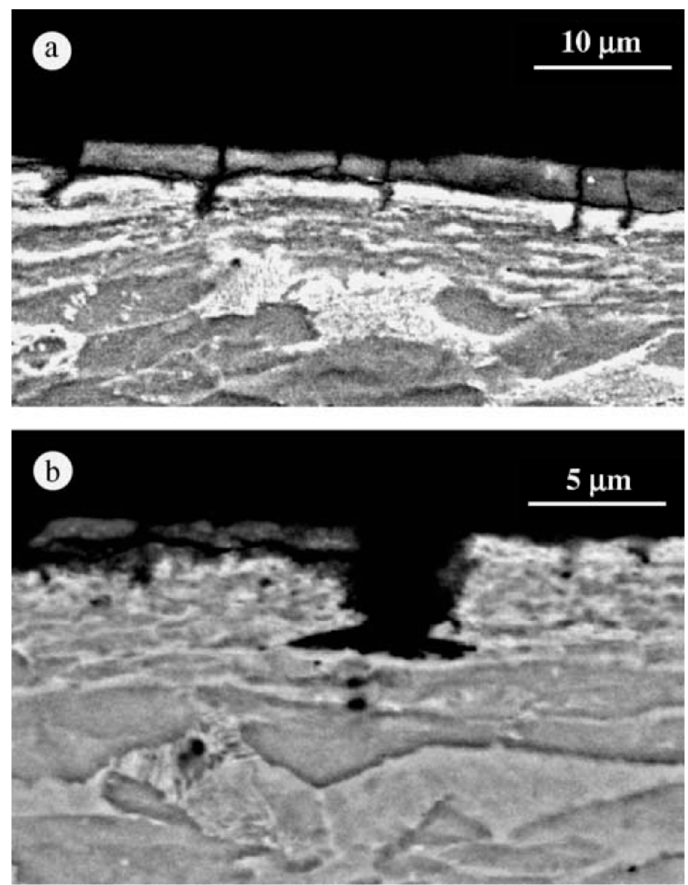
Figure 7. Initiation of transgranular SCC cracks from the surface oxide: ( a ) region 1, and ( b ) region 2 [32]. Reproduced with permission from [32], Elsevier, 2003.